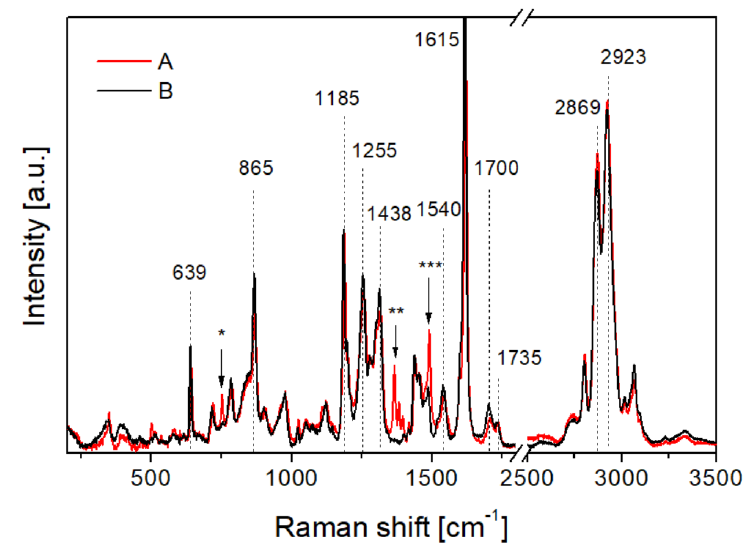
Figure 6. Raman spectra of polyurethanes: A — 80 ShA sample, B — 90 ShA sample.